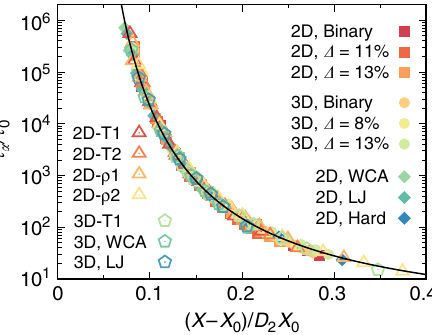
Fig. 5 Universal relationship between structural order and dynamics. Macroscopic structure relaxation time τ α as a function of the rescaled structural order ð X (cid:2) X 0 Þ = D 2 X 0 for sixteen different systems in the supercooled regime. Filled symbols: 2D BM and PM ( Δ ¼ 11 % and 13 % ), and 3D BM and PM ( Δ ¼ 8 % and 13 % ) with harmonic interactions; and 2D polydisperse mixtures ( Δ ¼ 13 % ) with WCA, LJ and purely hard interactions. For these nine major systems, both macroscopic and microscopic properties are studied. Open symbols: seven additional systems controlled by temperature T (2D-T1,2 with fi xed volume fractions ϕ ¼ 0 : 88 and 0.86, respectively; 3D-T1 with ϕ ¼ 0 : 72; and 3D WCA and LJ) or density ρ (2D- ρ 1,2 at fi xed temperatures T ¼ 10 (cid:2) 3 and 10 (cid:2) 4 , respectively). If not speci fi ed, the interaction is harmonic repulsion.